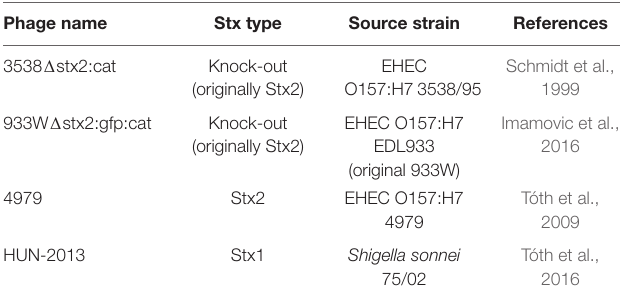
TABLE 3 | Attempts for Lysogenization and Phage